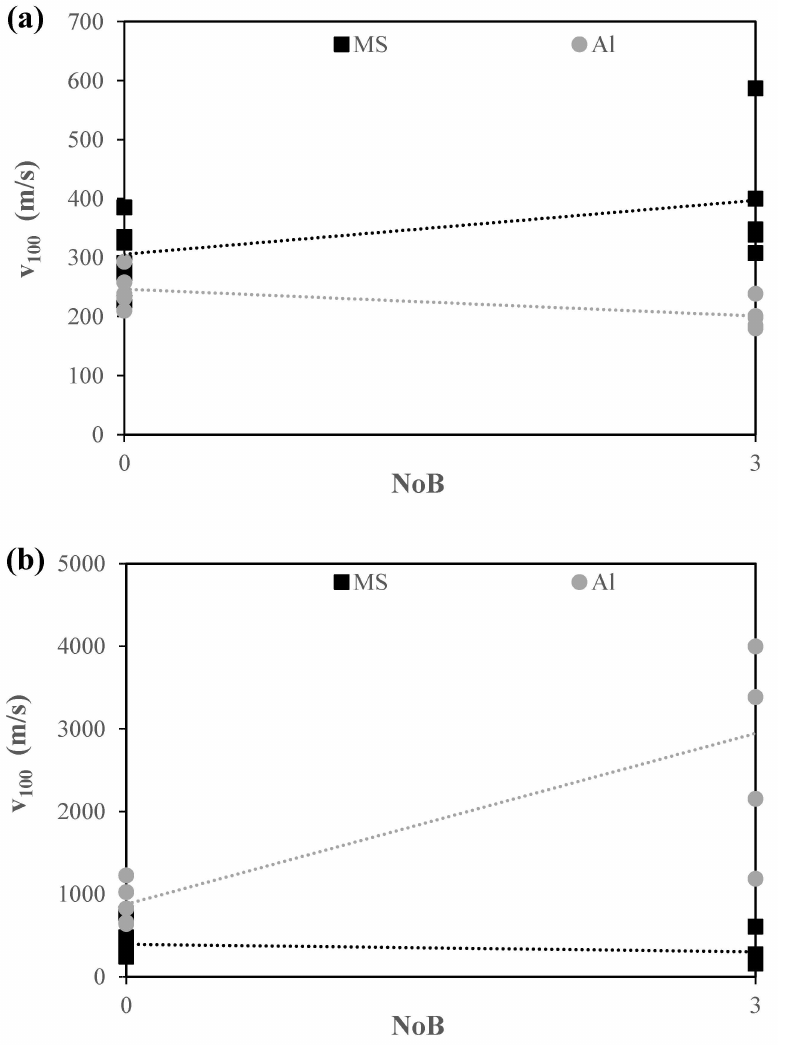
Figure 7. Influence of bends on the propagation of pressure waves for Al and MS along ducts: ( a ) Wave propagation speed between position 1 and 2, ( b ) Wave propagation speed between position 2 and